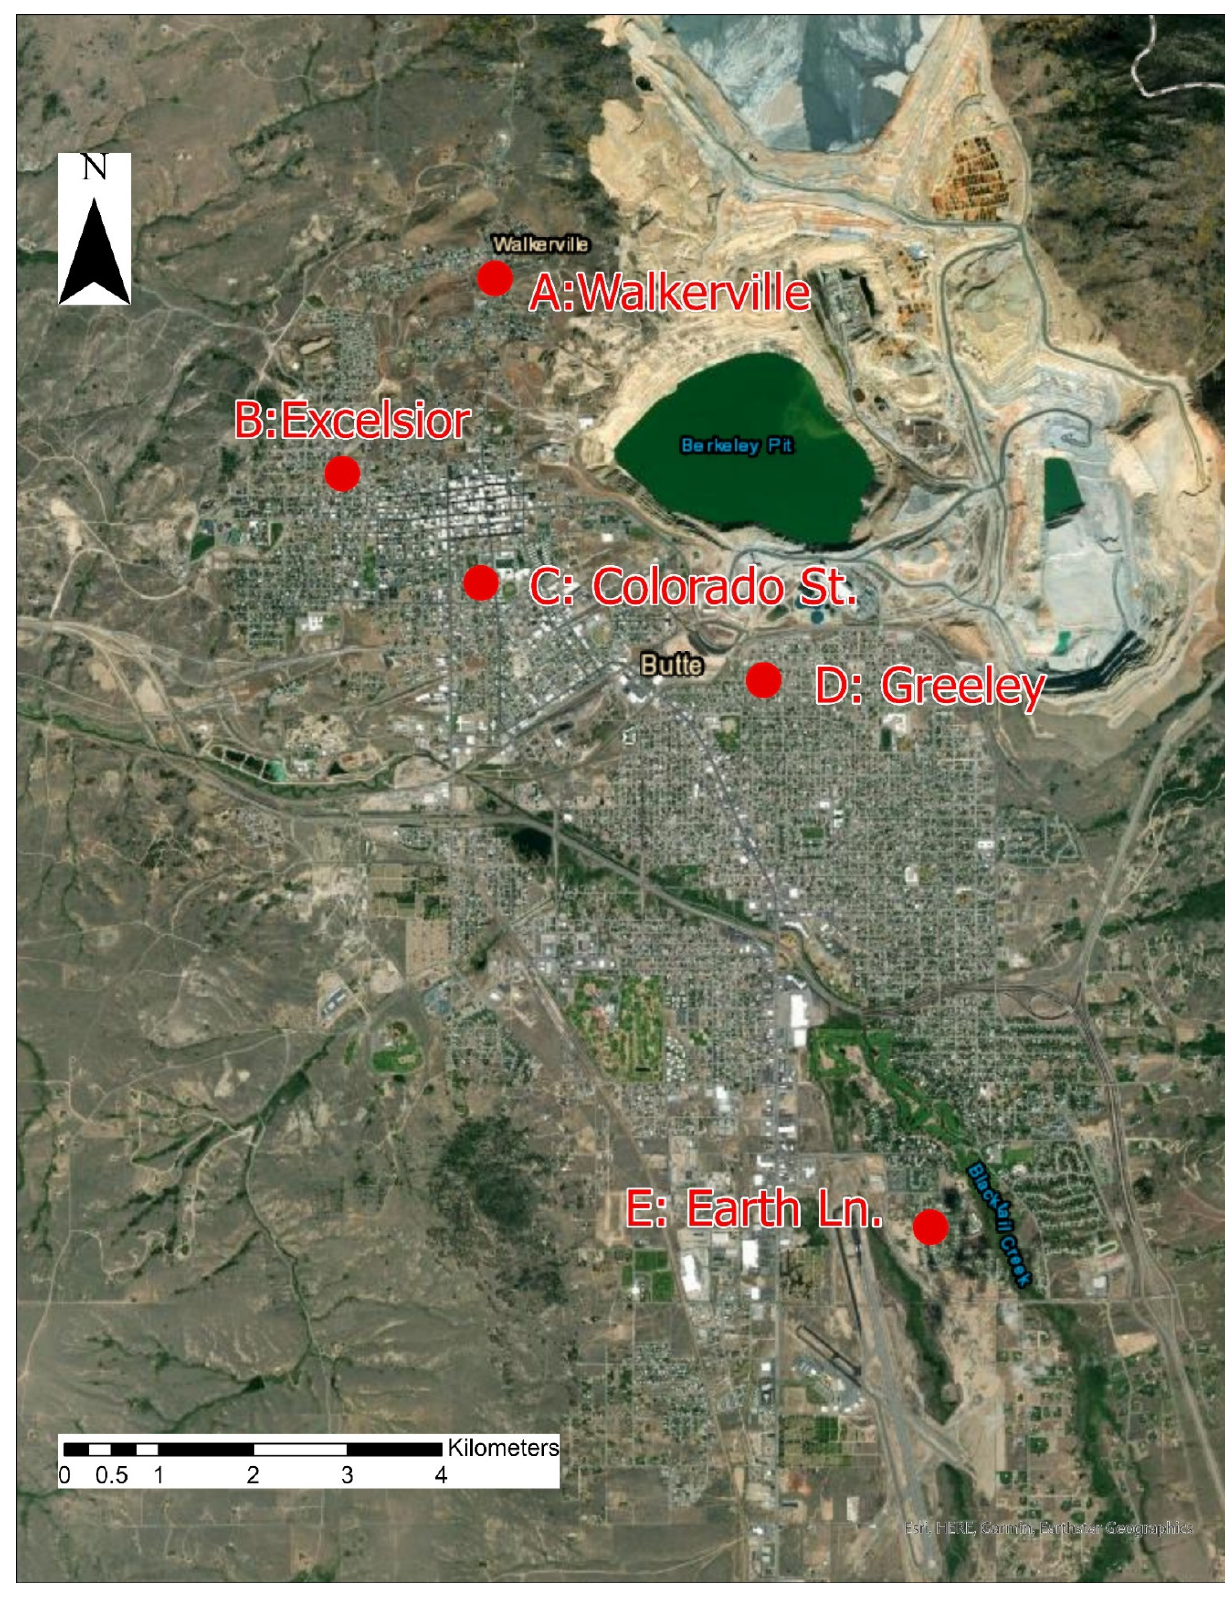
Figure 2. Study area map with air quality monitoring station locations.